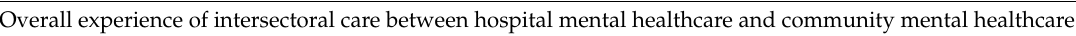
Table 2. Interview